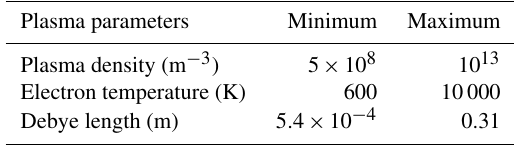
Table 1. Expected plasma